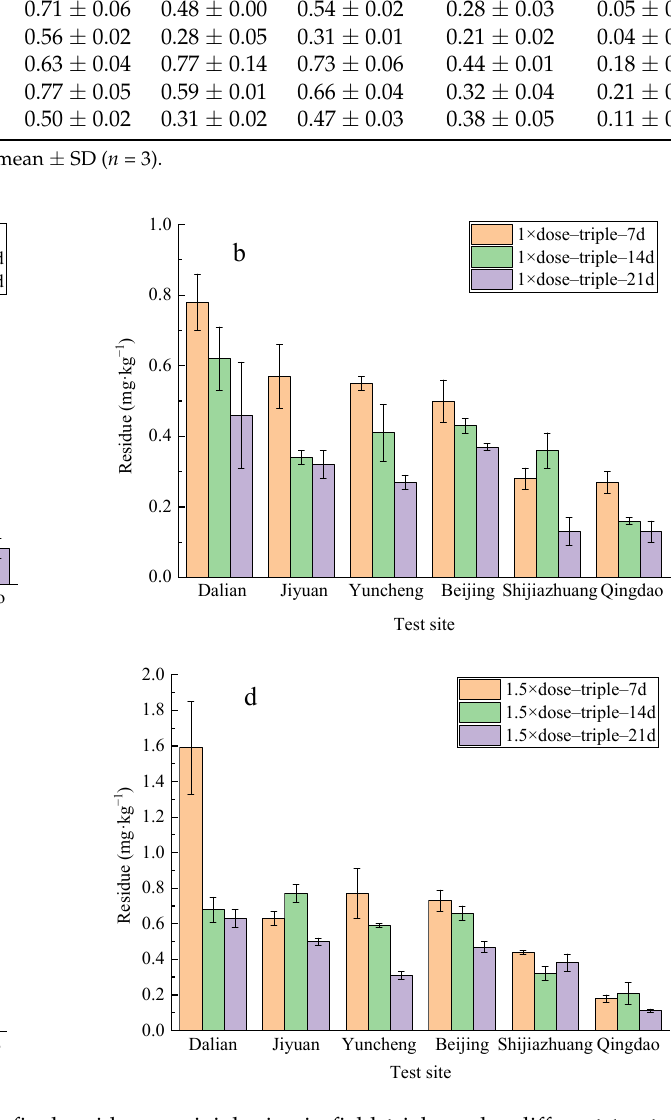
Table 4. Summary of final residues.